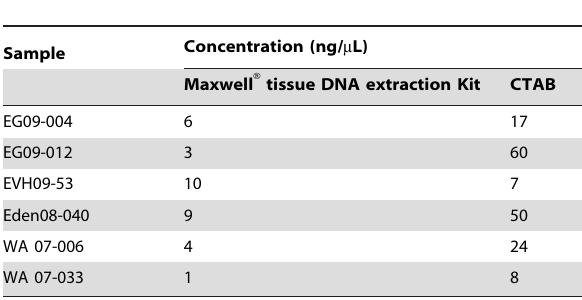
Table 3. Samples analysed using the SNP-GT nanofluidic